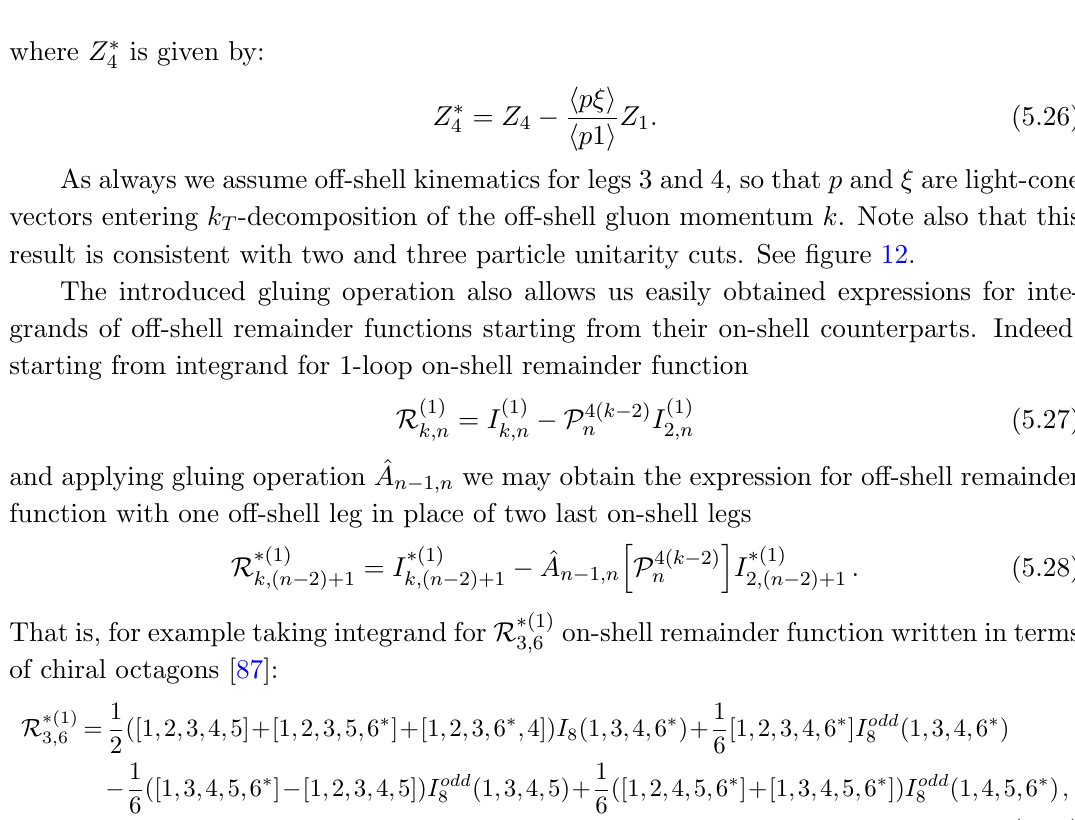
Figure 12 . Unitarity cuts for A ∗ (2) (Ω 1 , Ω 2 , g ∗ ) where only 1 /l 2 propagators have been cut. 3 2 , 2+1 Vertical red line represents cuts of corresponding propagators. Grey blobs are on-shell amplitudes with k = 2 , 3. Dark grey blobs are Wilson line form factors with k = 2 ,